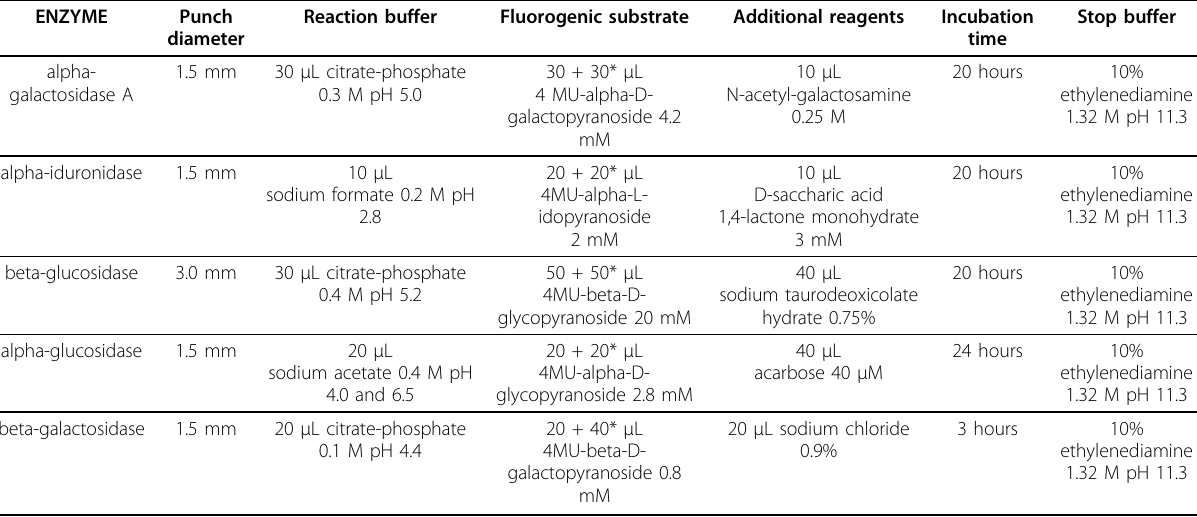
Table 1 Assay conditions for each enzyme activity assay ENZYME Punch diameter